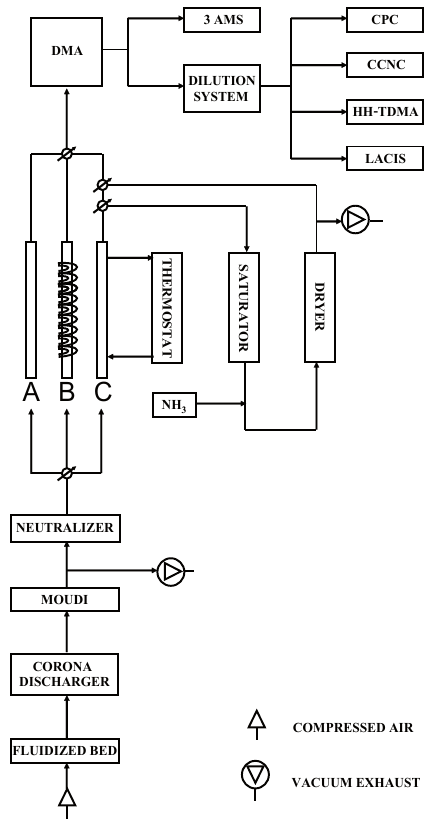
Fig. 1. Sketch of the generation, coating and size selection of the particles. Also included are the different instruments which mea- sured during